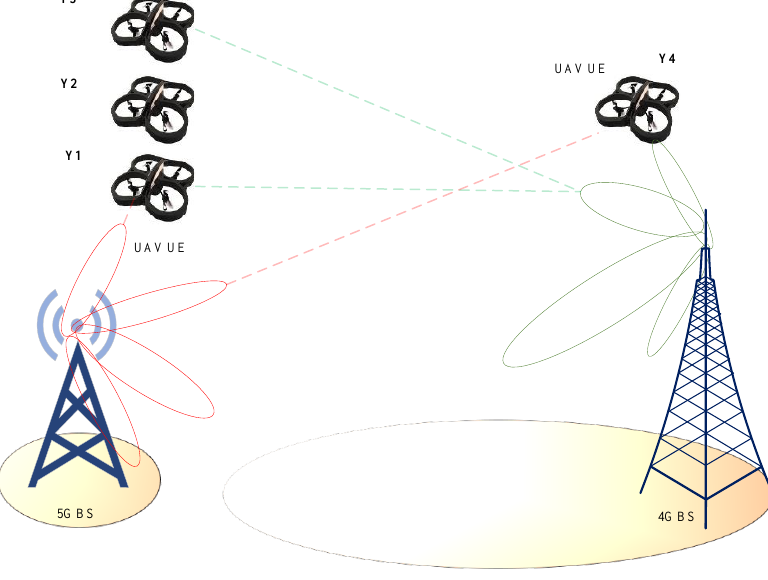
Figure 3. UAV connection via side lobes in a future ultra – dens heterogenous network. For locations Y2 and Y4 in Figure 3, the picture can be expanded to include a large number of BS s, signifying that the rate of HO for UAVs will be more excessive than con- ventional or traditional networks. Increasing the UAV’s height will decrease the compet- itiveness of its service via the main lobes as long as the terrestrial BS antennas are slanted downwards. As a result, the service given to UAVs at high altitudes will be via the side lobes, which is not at the same level offered by the main lobes. Due to the increased po- tential of line – of – sight (LoS) at such high altitudes, UAV communication will suffer from uplink (UL) and downlink interference. This will create severe interference and naviga-